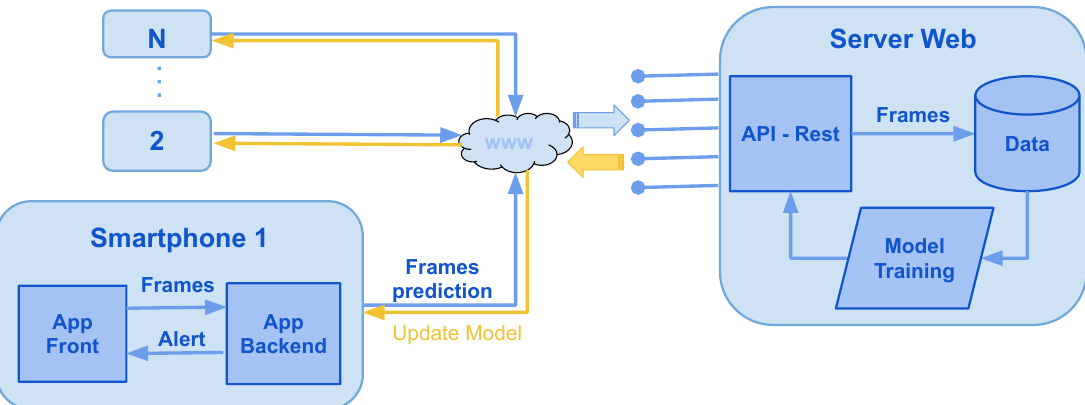
Figure 10. Software architecture for a mobile application and web